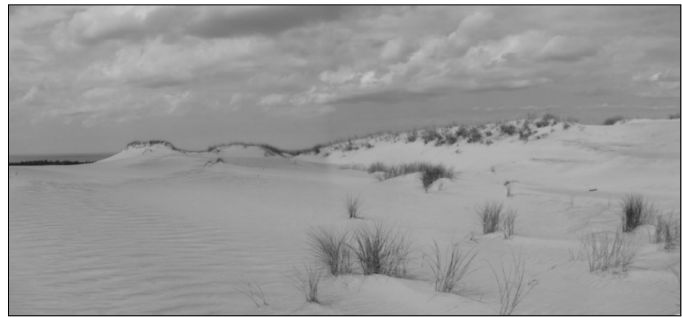
Figure 4. Key aesthetic appeal concepts of coastal dunes and forests of the Curonian Spit.